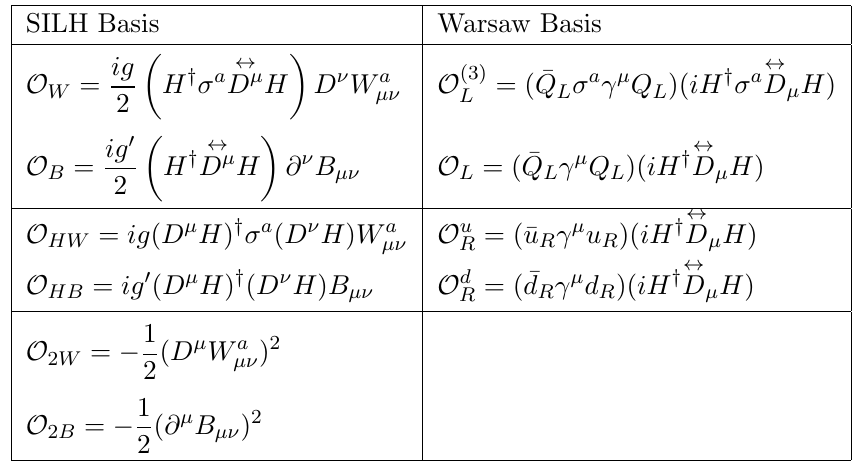
Table 3 . Dimension-six operators relevant for the high-energy longitudinal diboson production q (cid:22) q ! W L V L ; V L h that interfere with the SM, in the SILH basis [31] (left) and in the